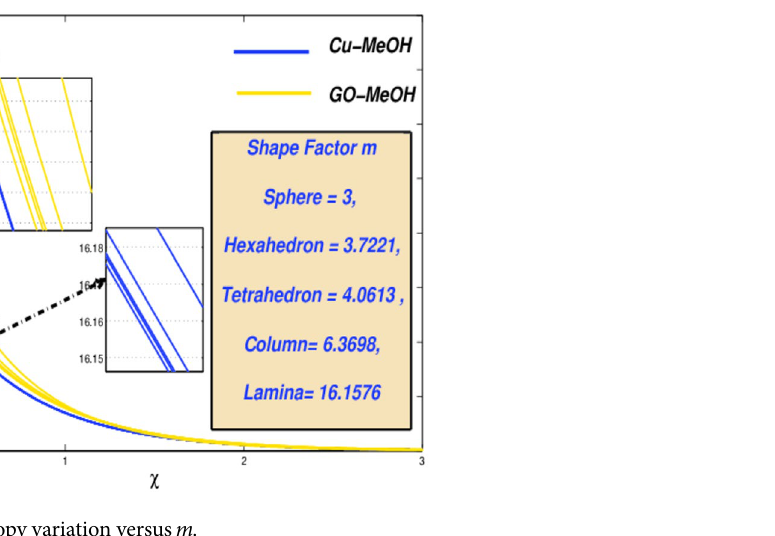
Figure 25. Entropy variation versus m